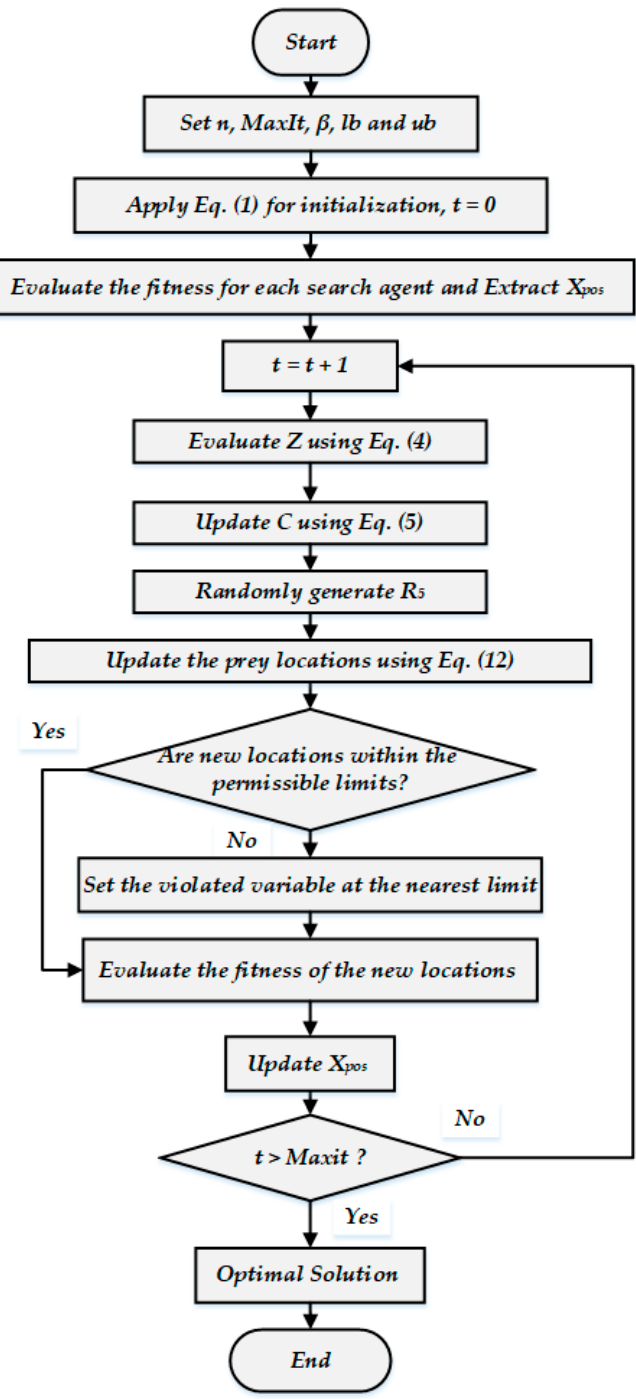
Figure 1. Main steps of HPO